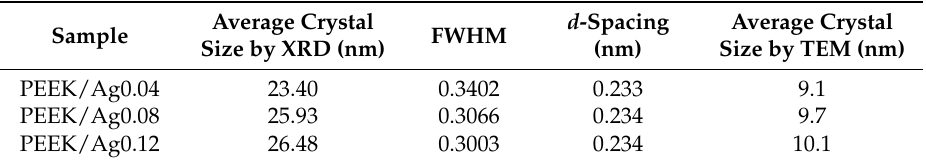
listed in Table